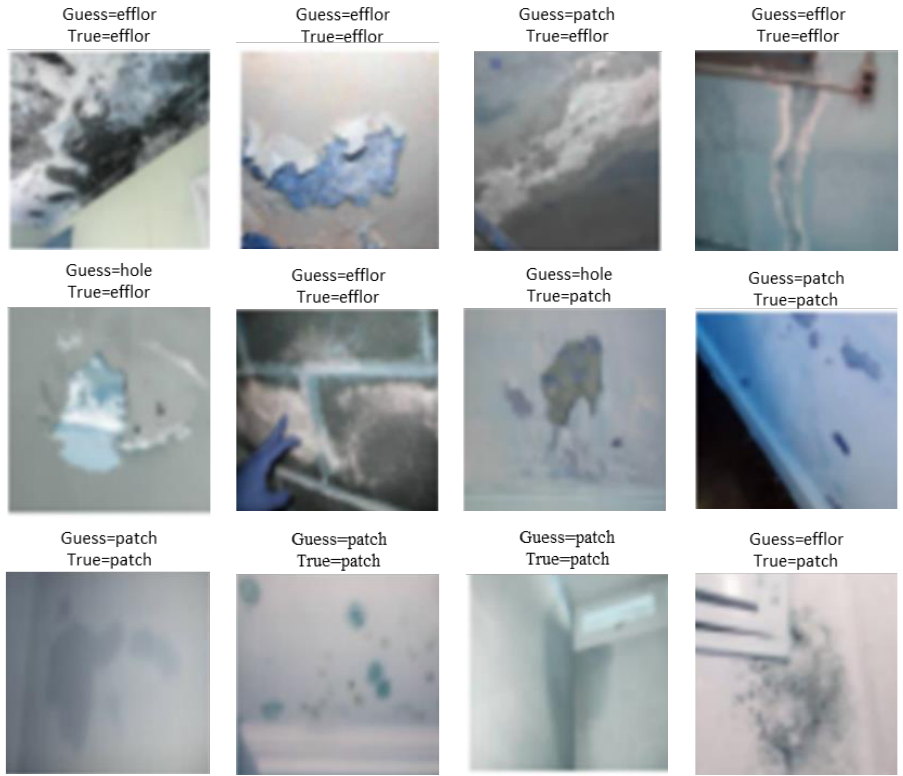
Figure 9. Prediction of wall defects by Conv2D VGG19 base model.